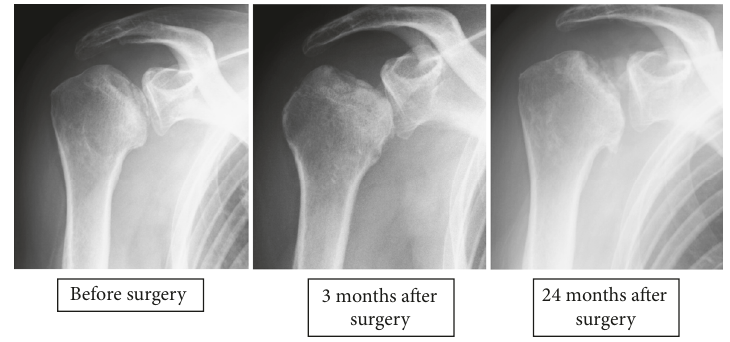
Figure 3: X-ray images of Case 3